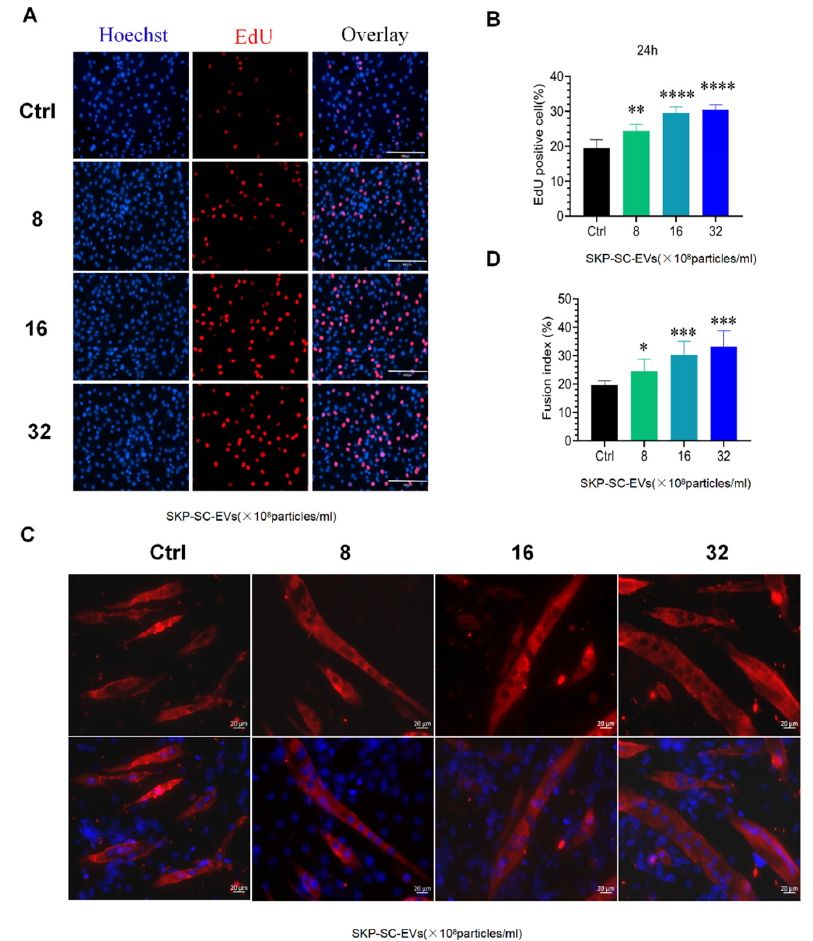
Figure 2. SKP-SC-EVs promote C2C12 cell proliferation and differentiation. ( A ) Representative EdU staining image of C2C12 cells 12 h after SKP-SC-EV or control treatment. Scale bar = 400 μ m. ( B ) Histogram indicating the number of proliferating cells in the EV and control (Ctrl) groups. n = 4, ** p < 0.01 and **** p < 0.0001 vs. Ctrl group. ( C ) SKP-SC-EV effects on the induction of C2C12 cell fusion. Scale bar = 20 μ m. ( D ) Histogram indicating the effect of different doses of SKP-SC-EVs on the myotube fusion index. n = 4, * p < 0.05 and *** p < 0.001 vs. Ctrl group. EVs, extracellular vesicles. SCs, Schwann cells; SKP, skin-derived precursors.